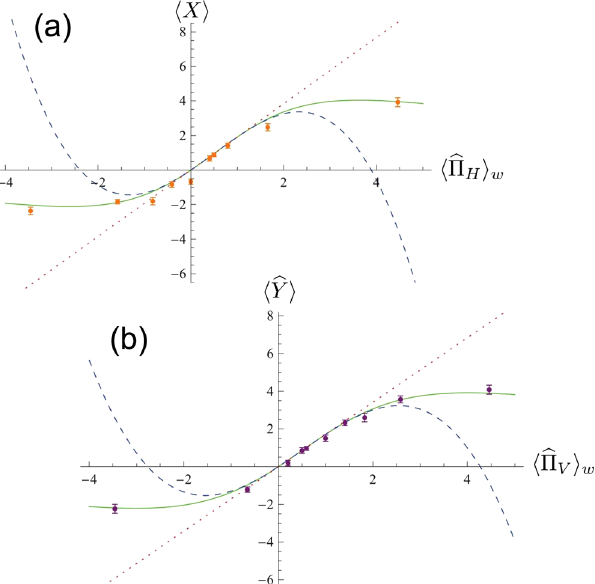
Figure 3. Obtained results for the acquisition with the 2.5-mm long birefringent crystal pair. Plot ( a ) ( b ): behavior of the meter observable ˆ X ( ˆ Y ) with respect to the expected weak value 〈Π 〉 ˆ experimental data. Solid green curve: complete theory of the von Neumann coupling occurring in the birefringent crystal. Dashed curve: third order approximation of the complete theory in the limit of weak coupling (  g 1 2 ). Dotted line: first order approximation of the complete theory for  g 1 2 , the one used for the weak value